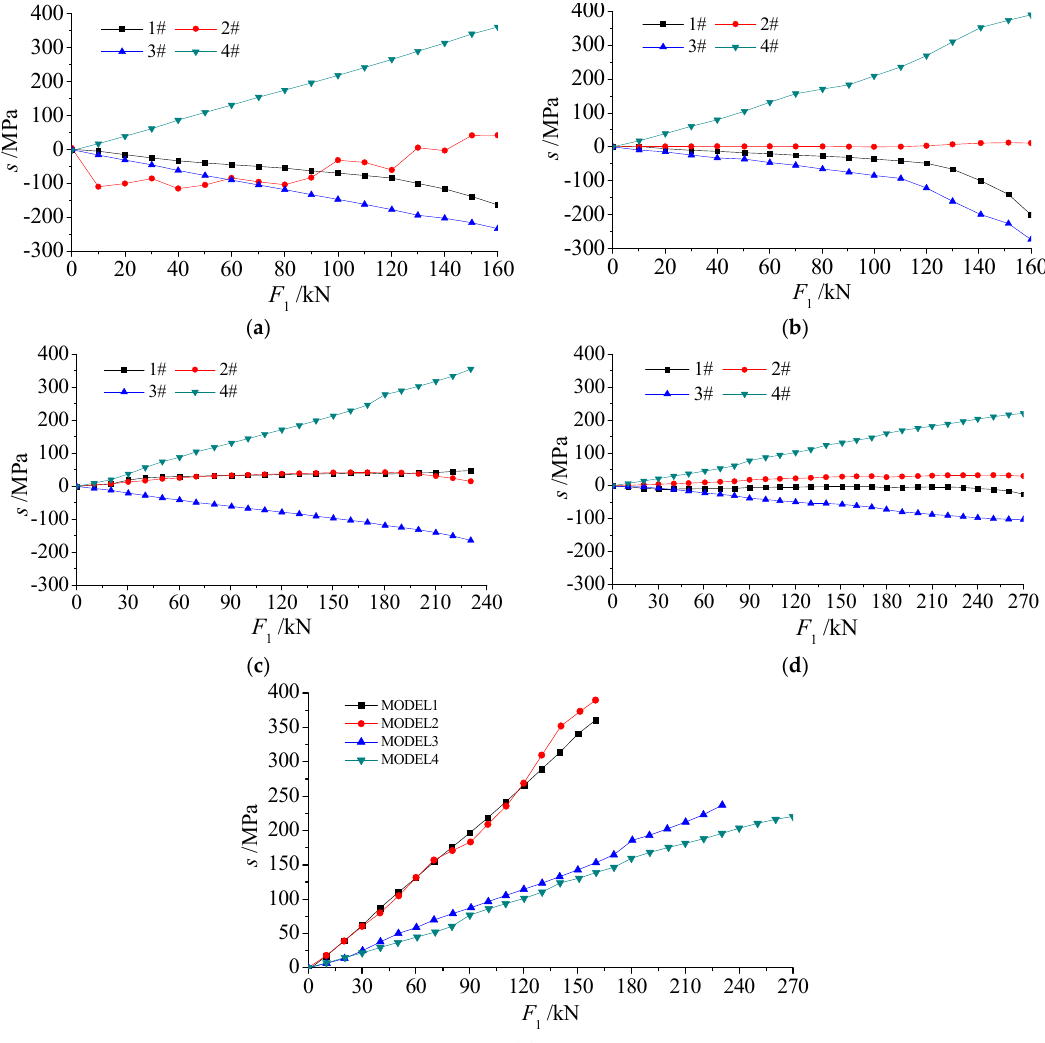
Figure 13. Stresses in top arch: ( a ) stresses in model 1; ( b ) stresses in model 2; ( c ) stresses in model 3; ( d ) stresses in model 4; and, ( e ) comparison of stresses of gauge 4.